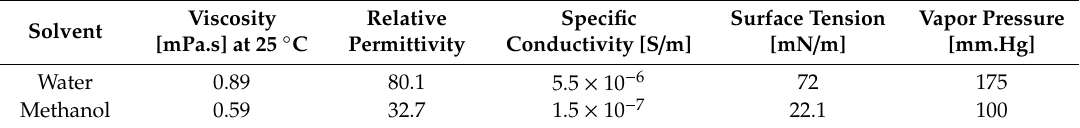
Table 1. Characteristics of the applied solvents.